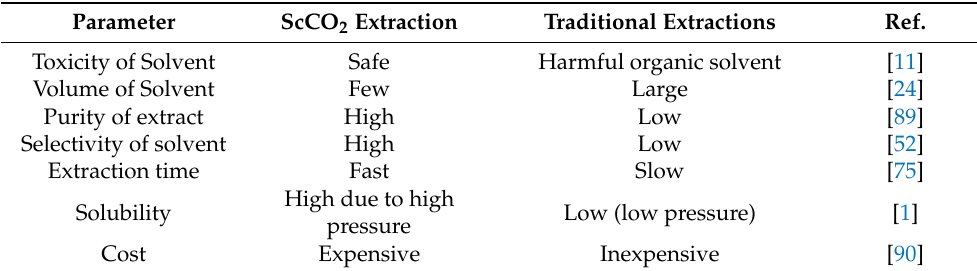
Table 6. Comparison of the ScCO 2 extraction with traditional